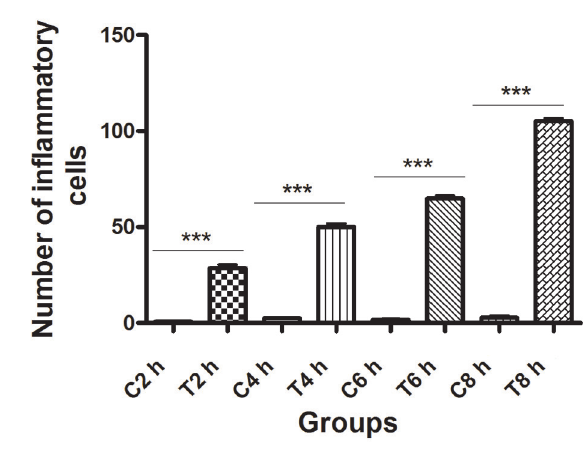
Figure 5. Quantitative analysis of the number of inflammatory cells 2, 4, 6 and 8 hours after PBS (control group) or venom (experimental group) injection. The difference is statistically significant (***p < 0.001/Kruskal–Wallis/Dunn’s post-test). C2h, C4h, C6h and C8h = control groups 2, 4, 6 and 8 hours after PBS injection, respectively. T2h, T4h, T6h and T8h = experimental groups 2, 4, 6 and 8 hours after venom injection,